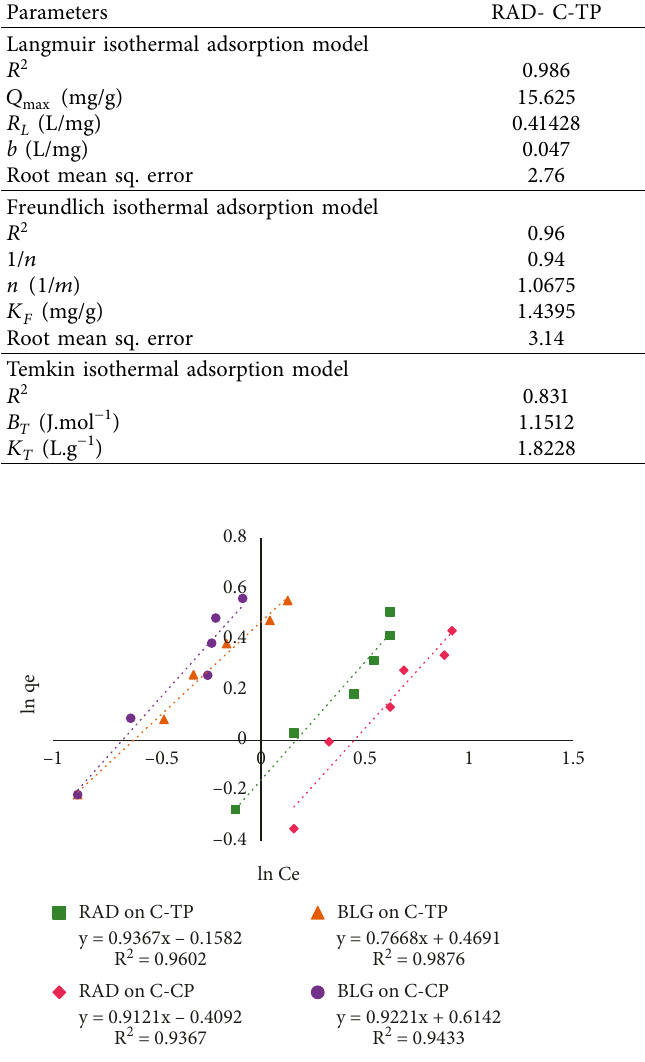
Figure 15: Evaluation of the Freundlich model regarding ad- sorptive dye removal efficiency of acid-treated biosorbents. Initial pH � 5, final pH for RAD on C-TP and C-CP � 4, BLG on C- TP � 4.5, and BLG on C-CP � binding constants “ K ” (L.g − 1 ) for adsorption of RAD on T C-TP and C-CP were 1.822 and 1.00, respectively, while for